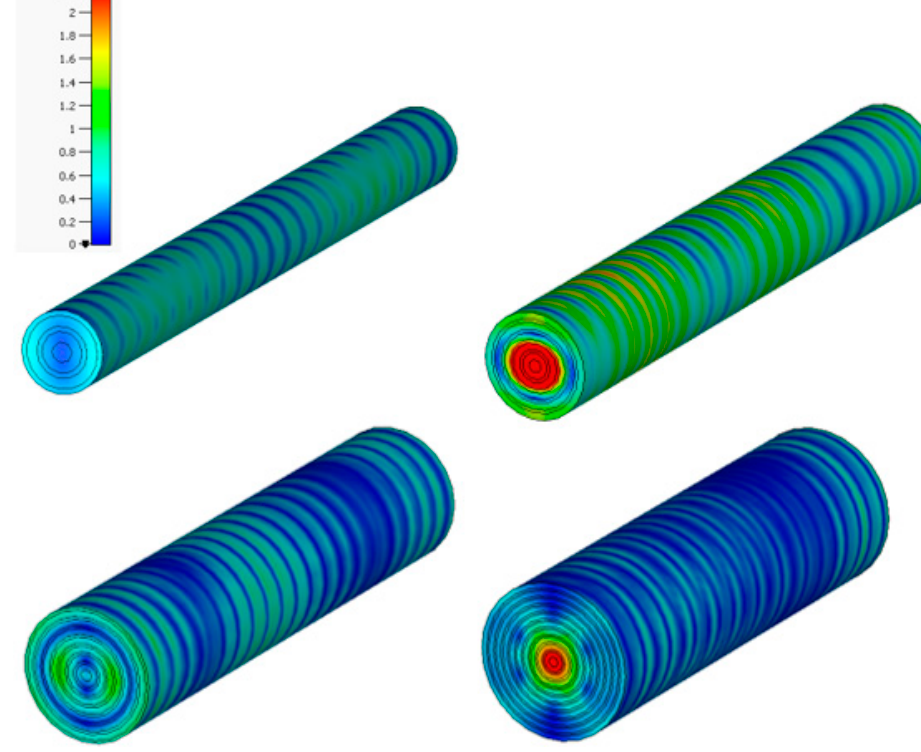
Figure 7. Electric field distribution inside dry poplar wood with different values of the number of growth rings with 50% permittivity variation at 3 GHz.